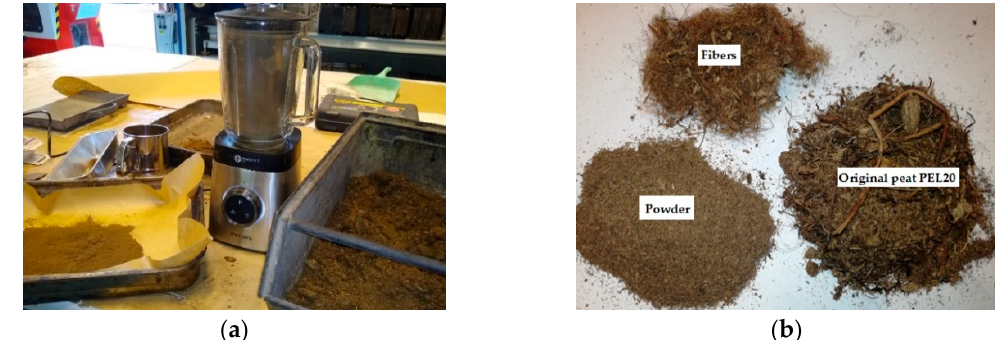
Figure 1. The preparation of peat material for testing: ( a ) grinding and ( b ) sieving.